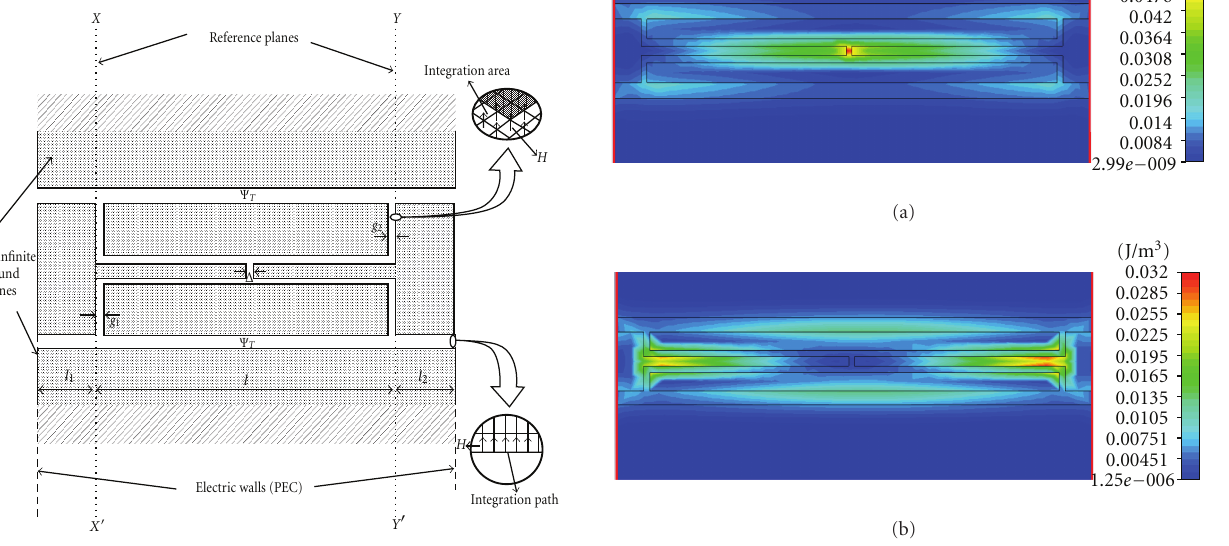
Figure 12: Energy density (J/m 3 ) under fundamental mode (a) electric energy density and (b) magnetic energy